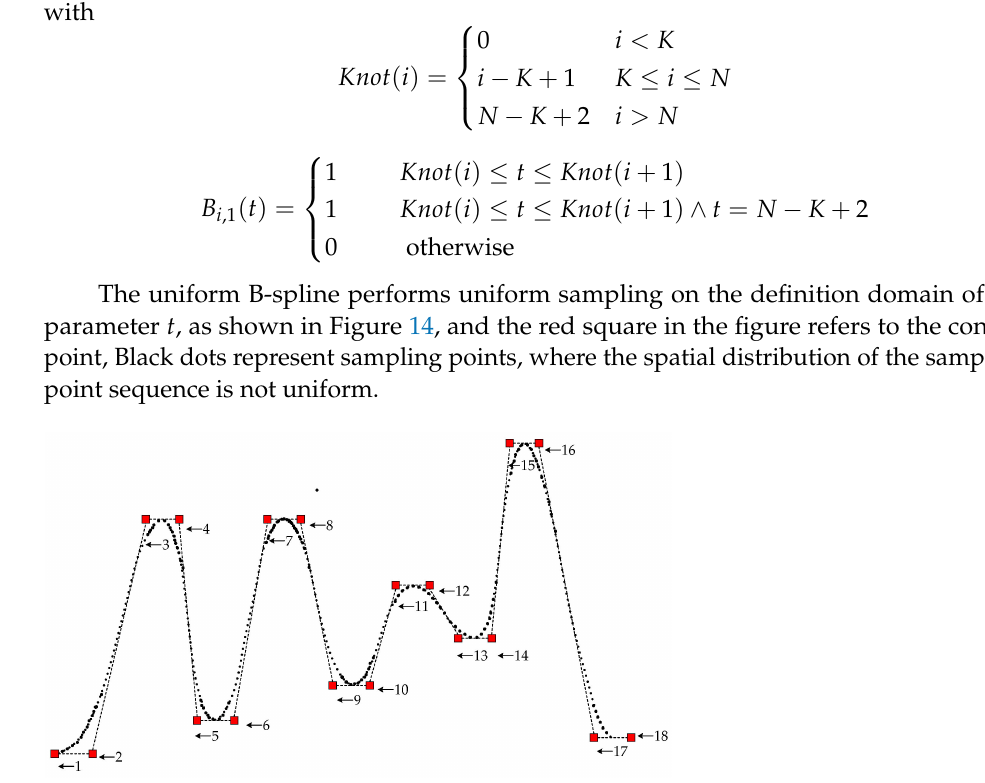
Figure 14. B-spline uniform sampling to smooth the